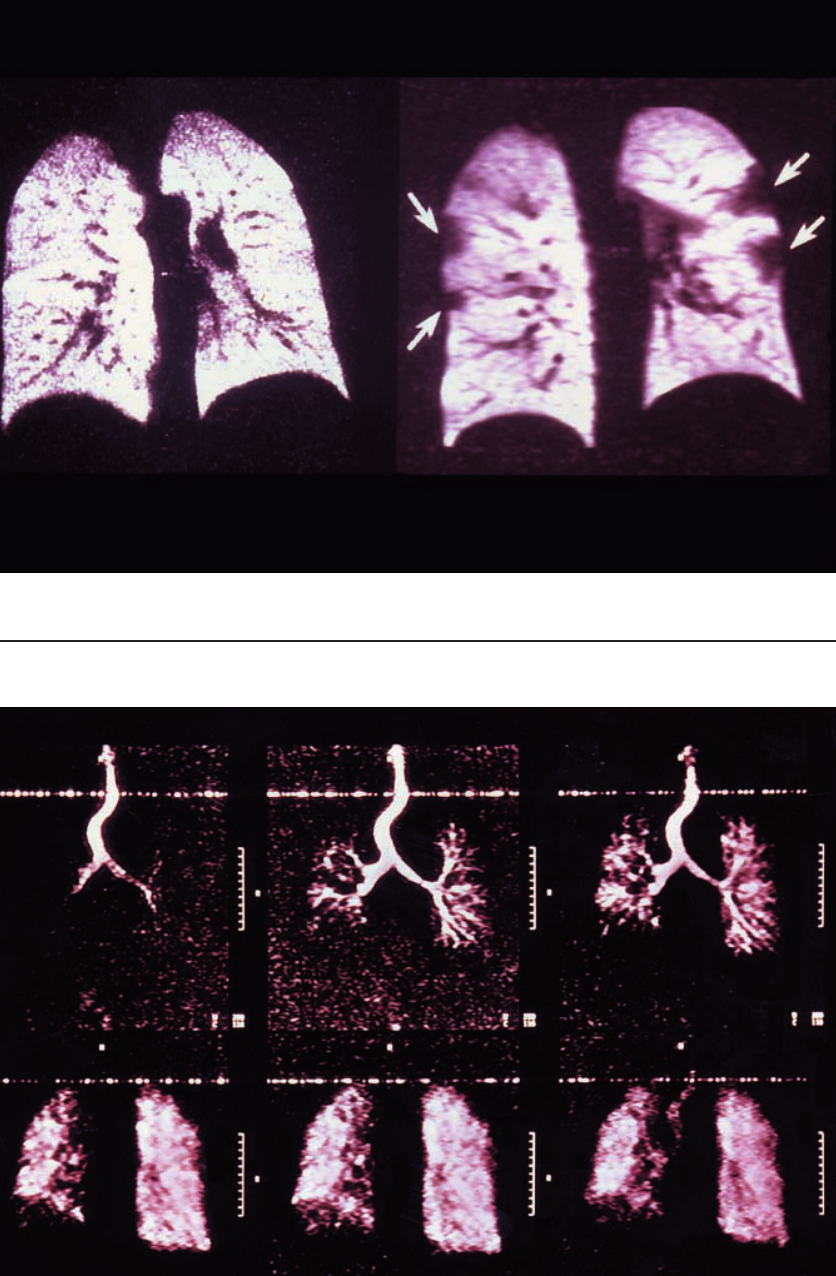
Figure 2 Pulmonary gas space morphology at 3 He-MRI in two clinically healthy sub- jects. Left, nonsmoker; right, smoker (10 pack years); arrows: areas of lung parenchyma with reduced or absent